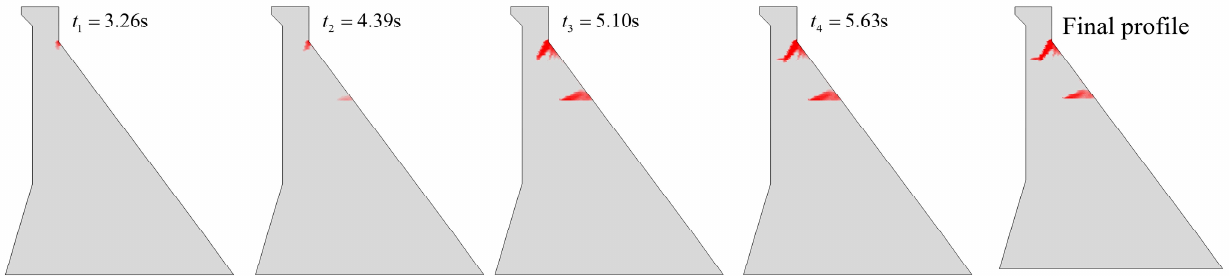
Figure 17. Damage characteristics of the dam with a weak layer for the four cases. Based on the analyses above from the aspects of the seismic responses and the failure characteristics, it can be inferred that the existence of a weak layer has a significant impact on the anti-seismic capacity of the dam. The defects of the weak RCC layer will change the dam’s response results and failure mode, and significantly increase the degree of de- formation and the sliding of the dam. What is more, the location of the weak layer also influences the response results of the dam during a strong earthquake. As a result, it may be concluded that weak layer effects must be taken into account in the seismic design of RCC dams and attention shall be paid to the combination quality of the weak layer during construction. Furthermore, while assessing the influence of weak layers, it is vital to ex- amine whether the responses are acceptable during earthquakes of different intensities, as the performance needs of dams vary depending on the conditions. 5.3. Damage Characteristics of the Dam with Higher Strength Grade Concrete in the Upper Part The dynamic analysis results above show that tensile failure occurs near the change in the downstream slope, which is attributed to the relatively low stiffness of the upper part. Therefore, the strength grade of the upper concrete is replaced with C20. The dam’s damage profiles in four cases are illustrated in Figure 18. It is clear that the damage to the dam has been significantly reduced compared to the results in Figure 17. From the per- spective of the scope of dam tensile damage, a higher strength of concrete can lead to less damage to the dam. However, the reduction in dam ductility and the increase in